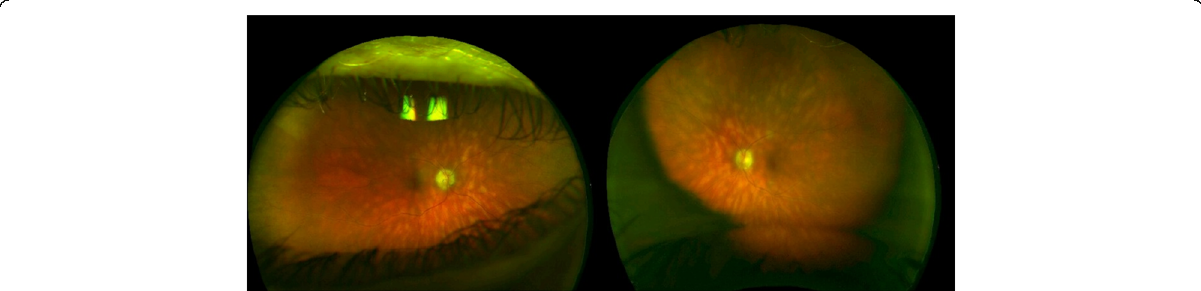
Fig. 5 Birdshot retinochoroiditis. Ultra-wide field fluorescein angiography of both eyes showing multiple, yellowish, subretinal lesions, radiating from the optic nerve to the retinal